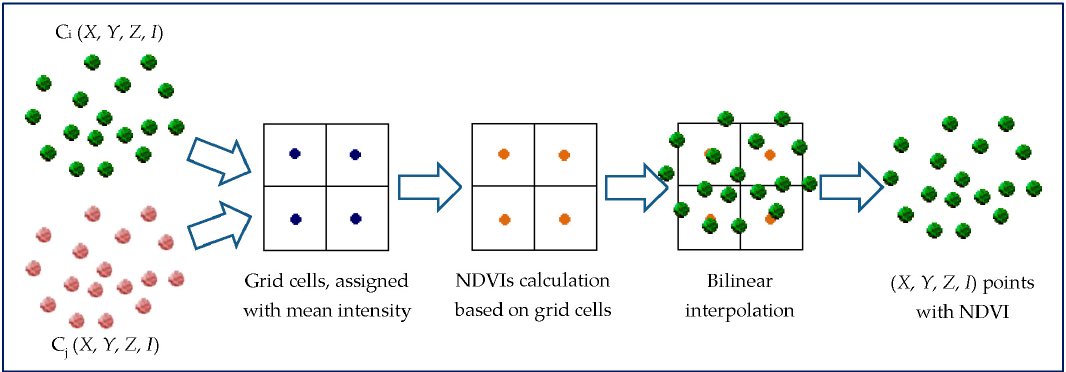
Figure 3. Spectral index calculation from 3D points.